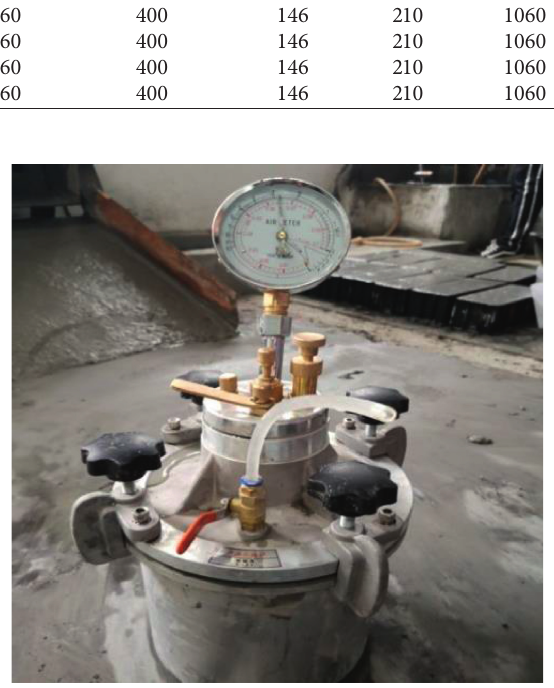
Figure 2: Gas meter.